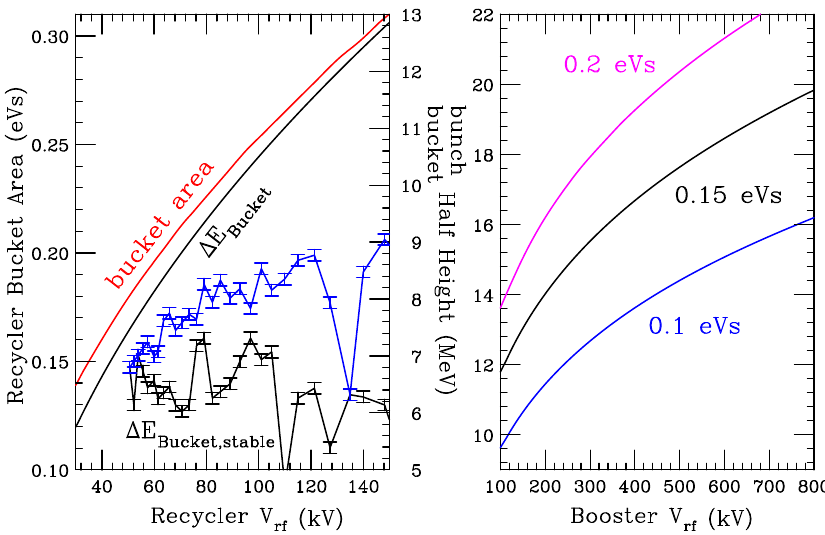
FIG. 7. Left: bucket area (red line) and bucket height (black line) versus rf voltage V for the Recycler. The typical operational rf Recycler rf voltage is 60 kV. Data points are obtained from numerical simulation without (black) and with (blue) second-harmonic rf compensation, where the dip at about 90 kV arises from the fifth-order resonance inside each slip-stacking bucket. The fourth-order resonance occurs around 150 kV Recycler rf voltage. Right: bunch height of the Booster beam at bunch areas 0.1, 0.15, and 0.2 eVs versus Booster rf voltage at extraction with the Booster rf sum of about 350 kV at extraction